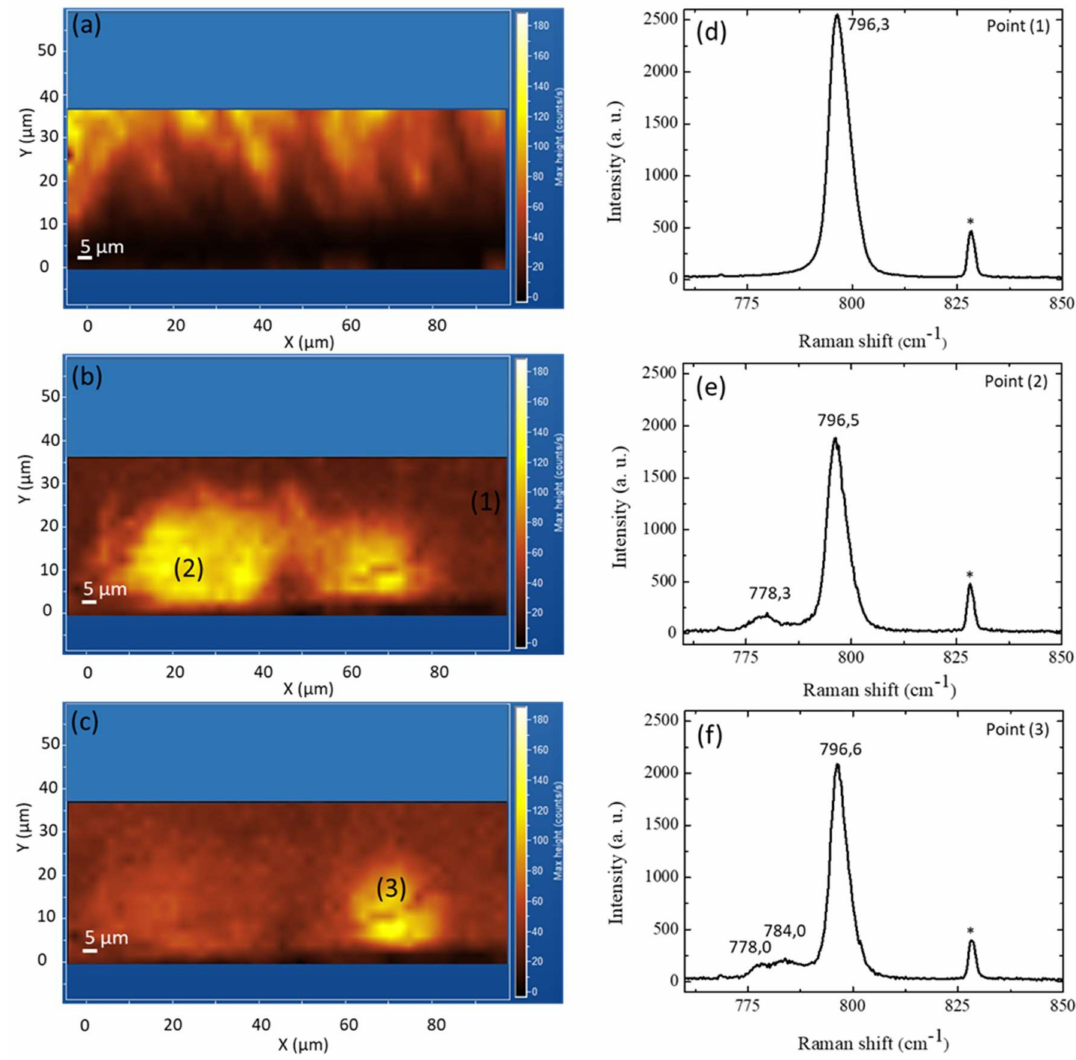
Figure 4. Micro-PL map ( a ) at 540 nm and micro-Raman map at ( b ) 778 cm − 1 and at ( c ) 784 cm − 1 of a 3C-SiC cross-section. The point 0 on the Y axis indicates the interface removed with the silicon. Average Raman spectra acquired in ( d ) region (1) on the map (b), ( e ) region (2) on the map (b), and ( f ) region (3) on the map (c). The peak localized at 828.37 cm − 1 (*) is the result of the